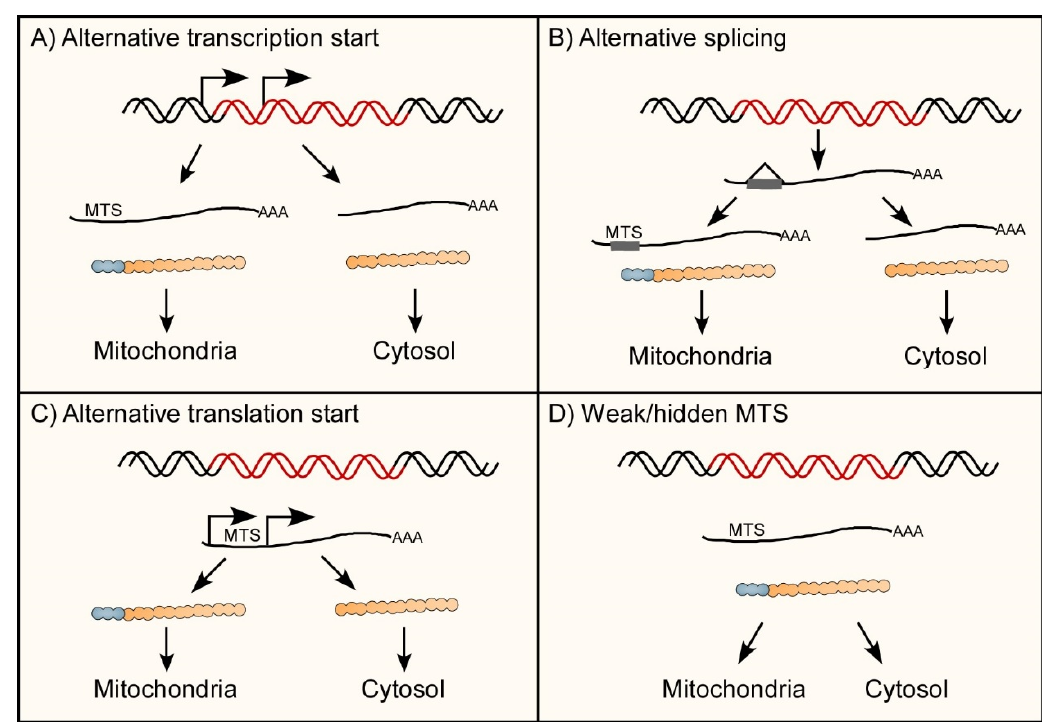
Figure 3. Schematic depiction of mechanisms for aaRS dual targeting. ( A ) A single gene can generate two transcripts by selection of alternative transcription initiation sites. One of the transcripts contains a coding region for an MTS, and leads to synthesis of mitochondria-destined protein, while the other transcript is devoid of this region hence the protein is retained in the cytosol. ( B ) A single pre-mRNA can generate two mature mRNAs by alternative splicing. An exon is retained in one of the transcripts and leads to synthesis of an MTS-bearing protein, which is destined to mitochondria. ( C ) A single mature mRNA can be translated into two proteins, through switching of the translation machinery between two start codons. ( D ) A single translated protein can have a weak or hidden MTS, which leads to partial retention in the cytosol.